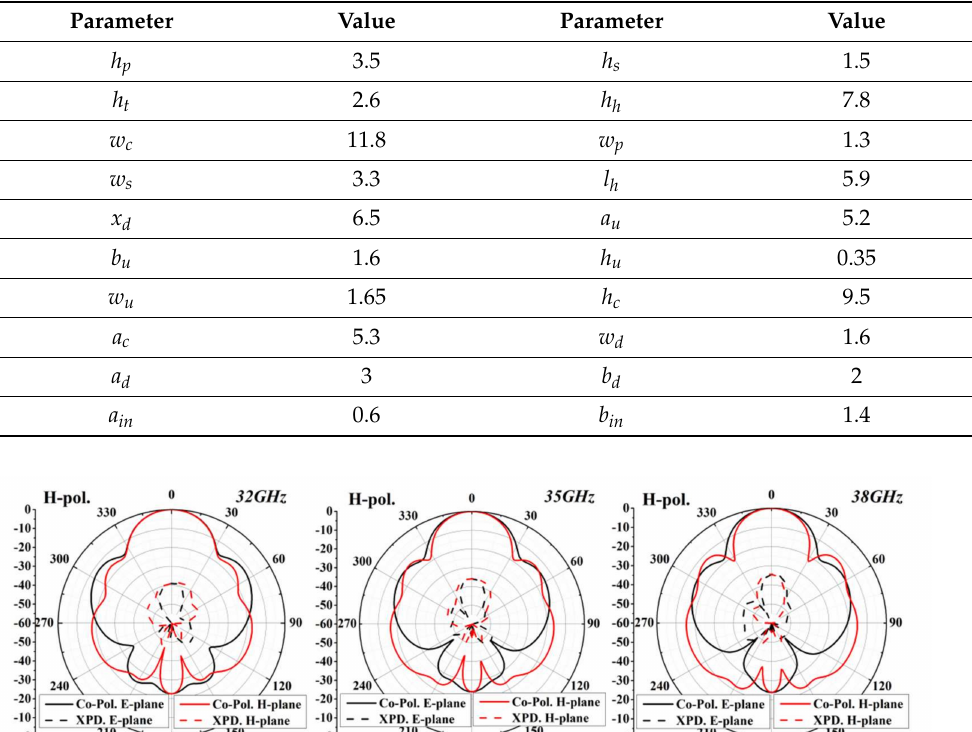
Table 1. Details of the proposed dual-polarization 2 × 2-unit ME-dipole subarray (unit: mm).